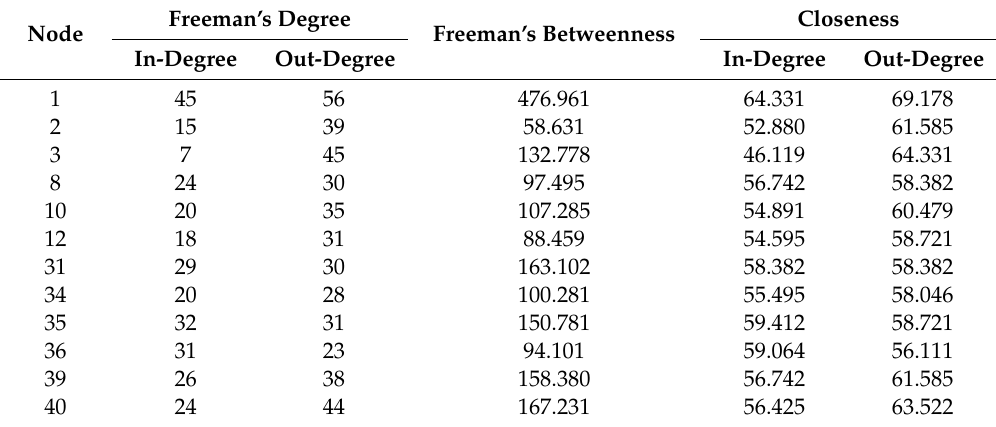
Table 6. Centrality of the doctor information interaction network (partial data)